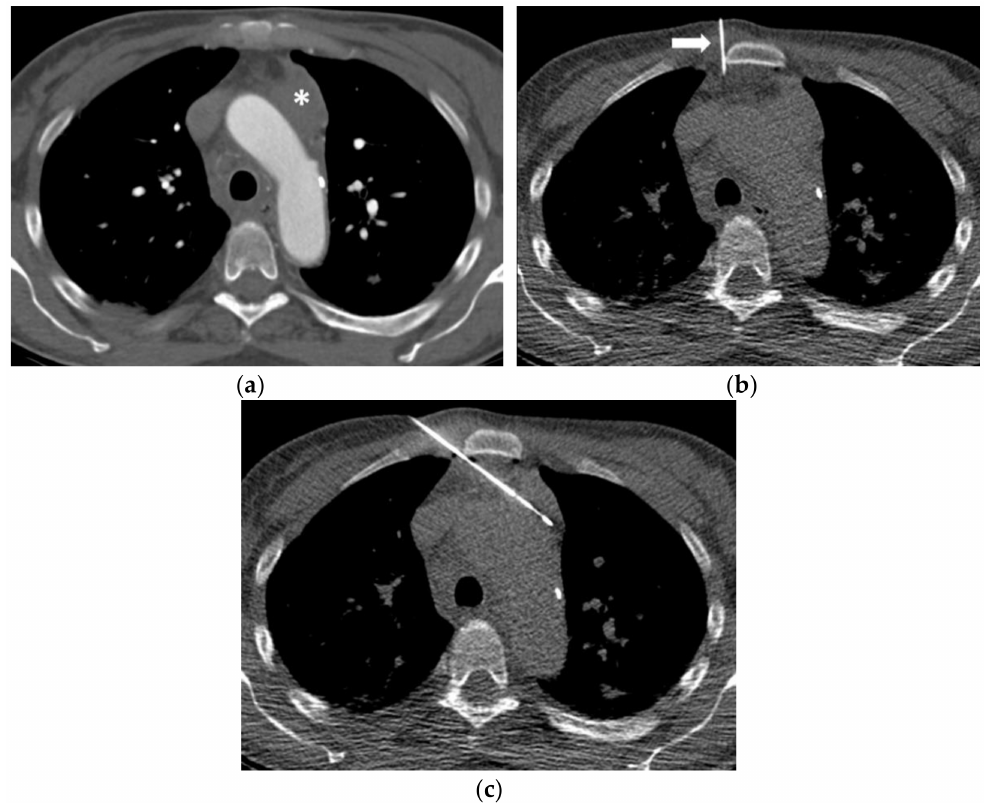
Figure 4. ( a ) A 48-year-old woman evaluated for suspicion of acute myeloid leukemia (AML) showing a left paraaortic mediastinal mass (asterisk). ( b ) In order to widen the parasternal soft tissue and create a safe access trajectory, 20 mL of sterile saline were injected into the parasternal fat tissue through a 22-Gauge fine needle (arrow). ( c ) Subsequently, an 18-Gauge Tru-Cut biopsy needle is safely inserted into the mass under CT fluoroscopy guidance. Histopathology confirmed a myeloid blast proliferation in line with an